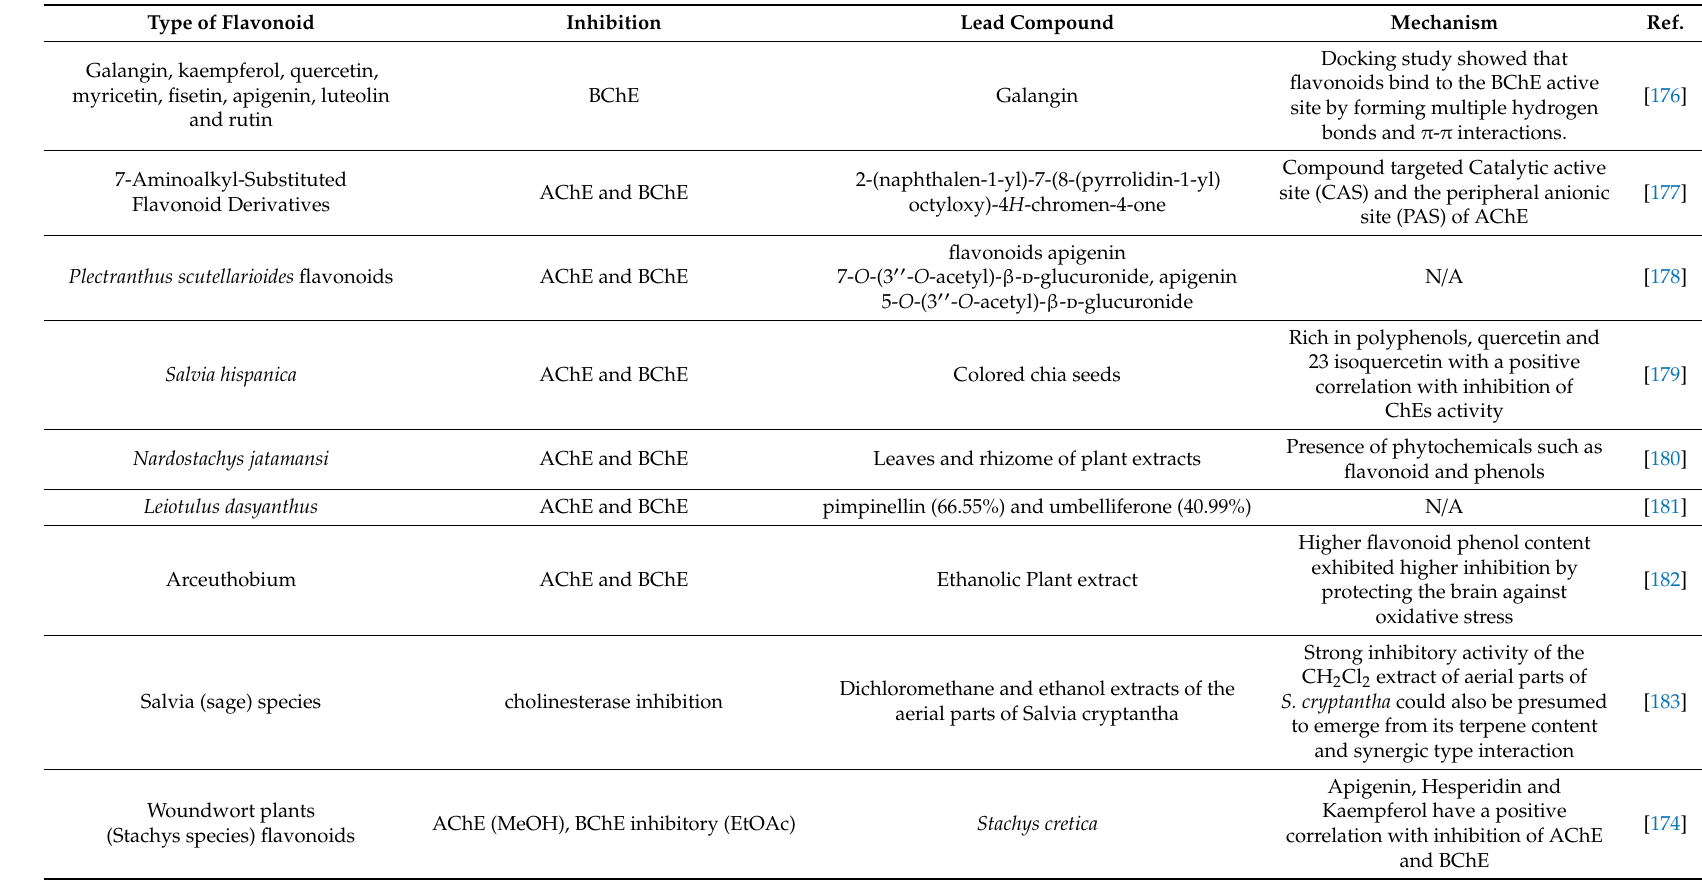
Table 4. Flavonoids with Anti-Alzheimer’s e ff